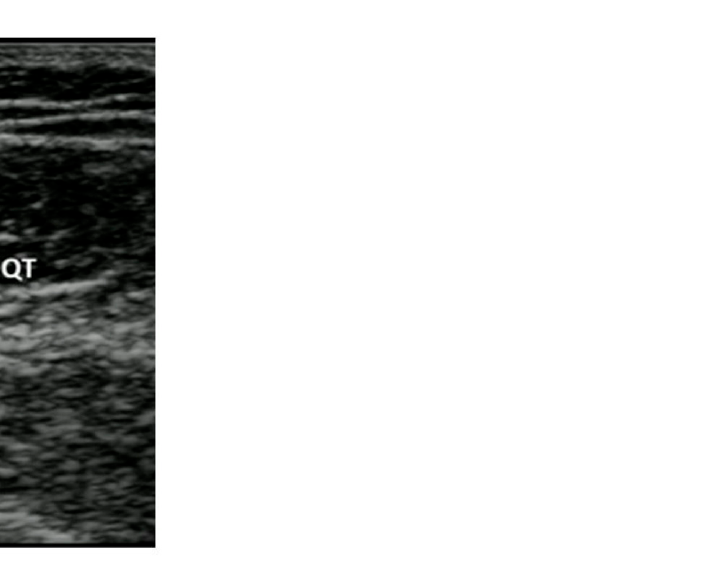
Figure 2 [33]. Thigh muscle thickness measurement. ST = subcutaneous tissue; RF = rectus femoris; VI = vastus intermedius; QT; quadricep’s thickness